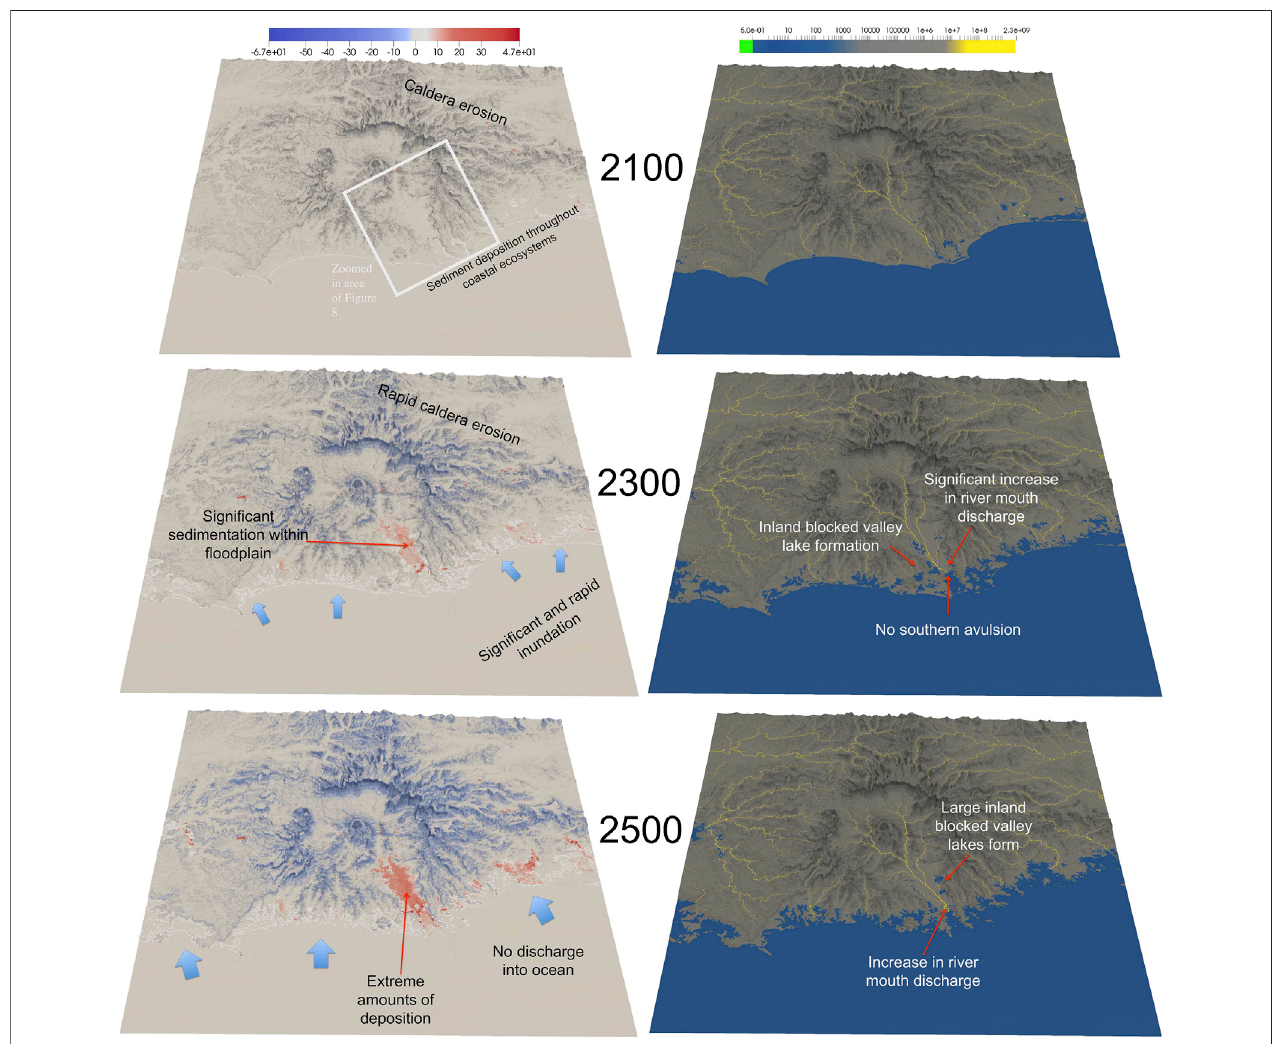
FIGURE7| VisualizationsofRepresentativeConcentrationPathways8.5AntarcticIceSheeterosionanddeposition,withredregionsindicatingareasofdeposition and blue regions indicating areas of erosion (m 2 /a) (left) . Visualizations of discharge with brighter yellow colors indicating greater discharge rates (m 2 /a) (right) demonstrating dynamic differences between 2100, 2300 and